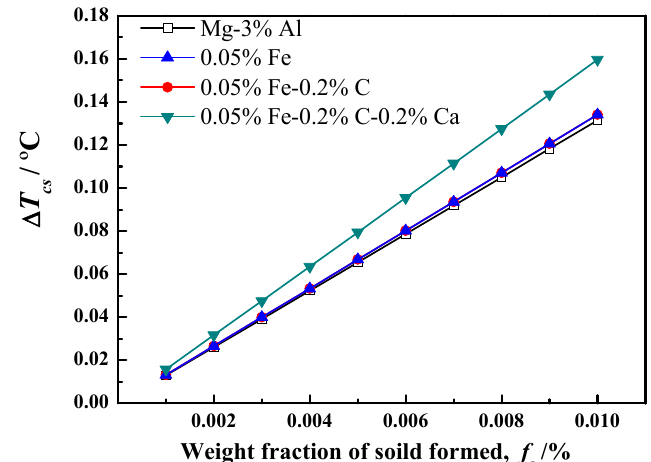
Figure 4. The totally constitutional undercooling ∆ T cs produced at the solid–liquid interface during the solidification. Table 1. List of the related parameters used in calculating the constitutional undercooling.